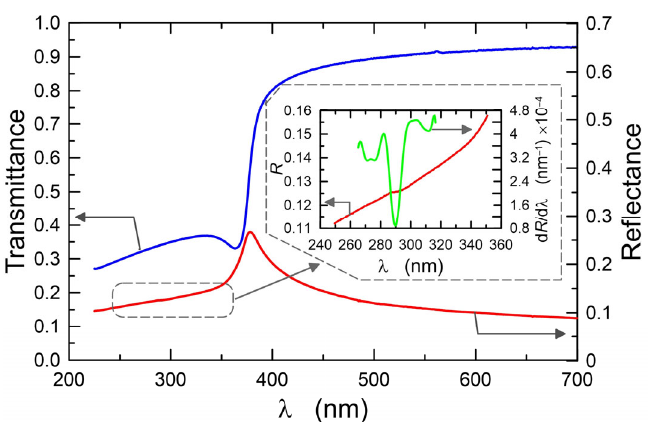
Figure 6. Transmittance and reflectance of ZnO ‐ 64 structure.